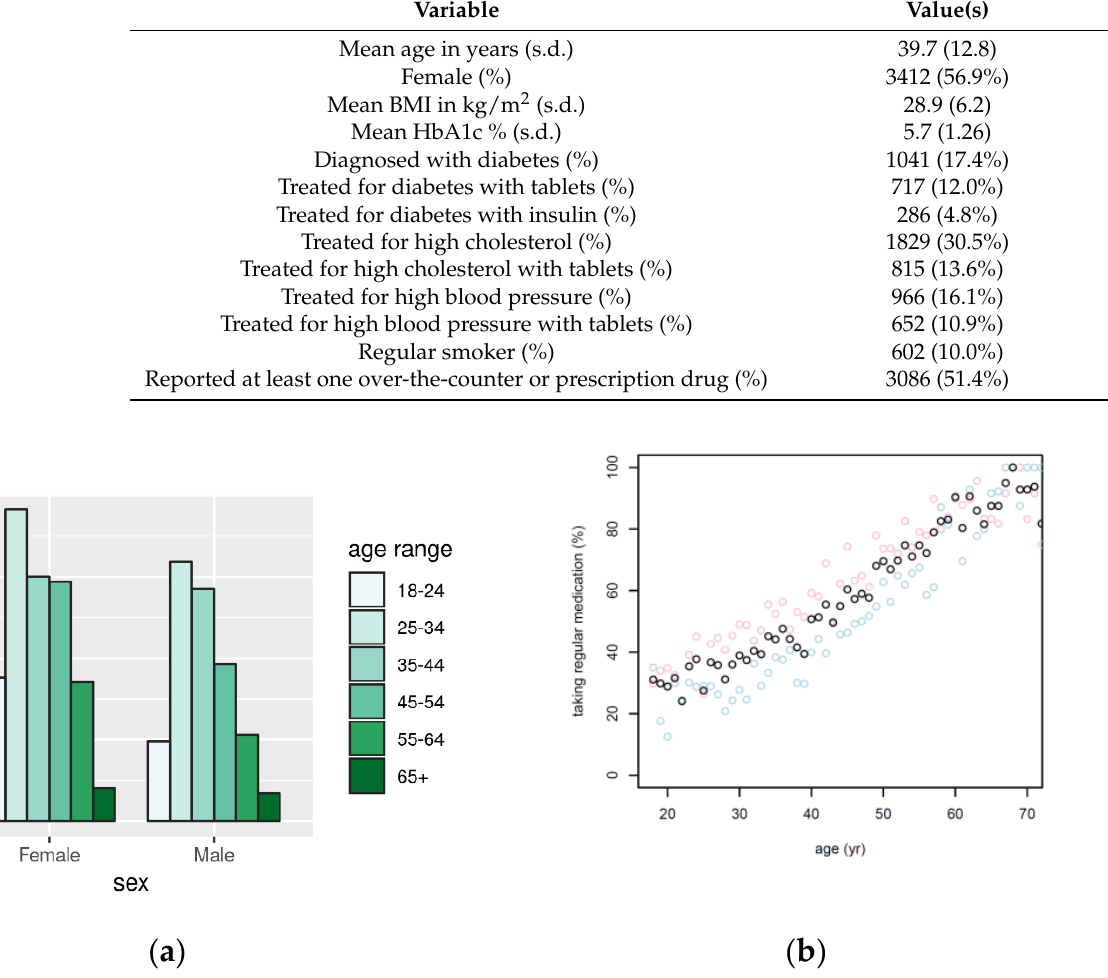
Figure 1. Histogram of the 6000 QBB participants included in this study, presented by sex and age ( a ); fraction of male (blue), female (pink), and all (black) QBB participants who self-reported using at least one over-the-counter or prescription drug, stratified by age ( b ).